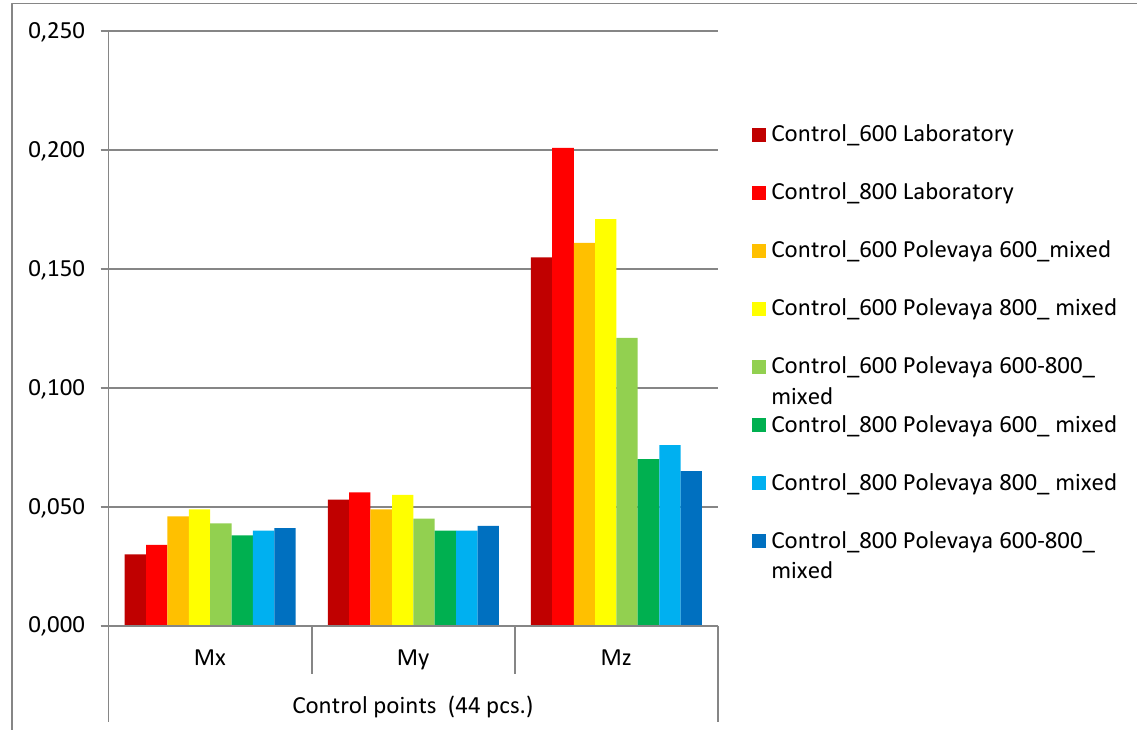
Table 1. The results of the accuracy estimation of the triangulation in PHOTOMOD